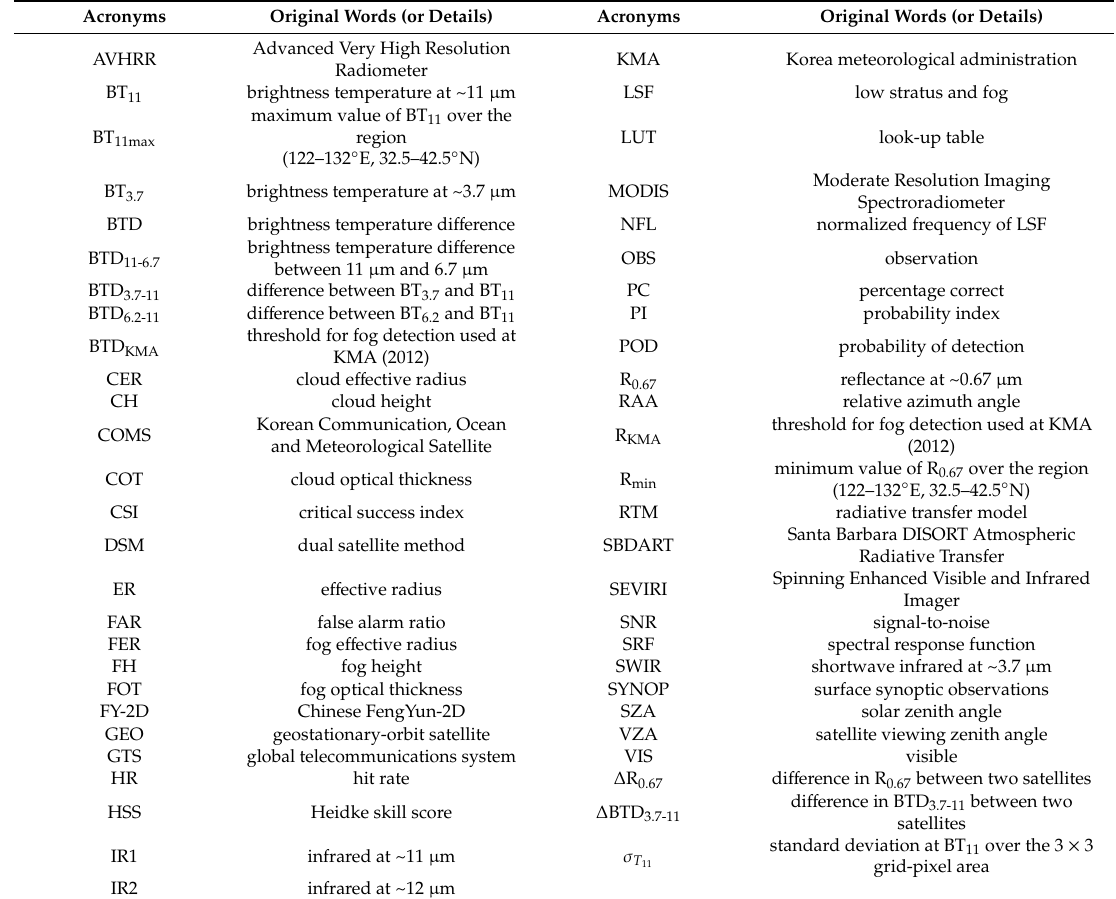
Table A1. List of acronyms used in this